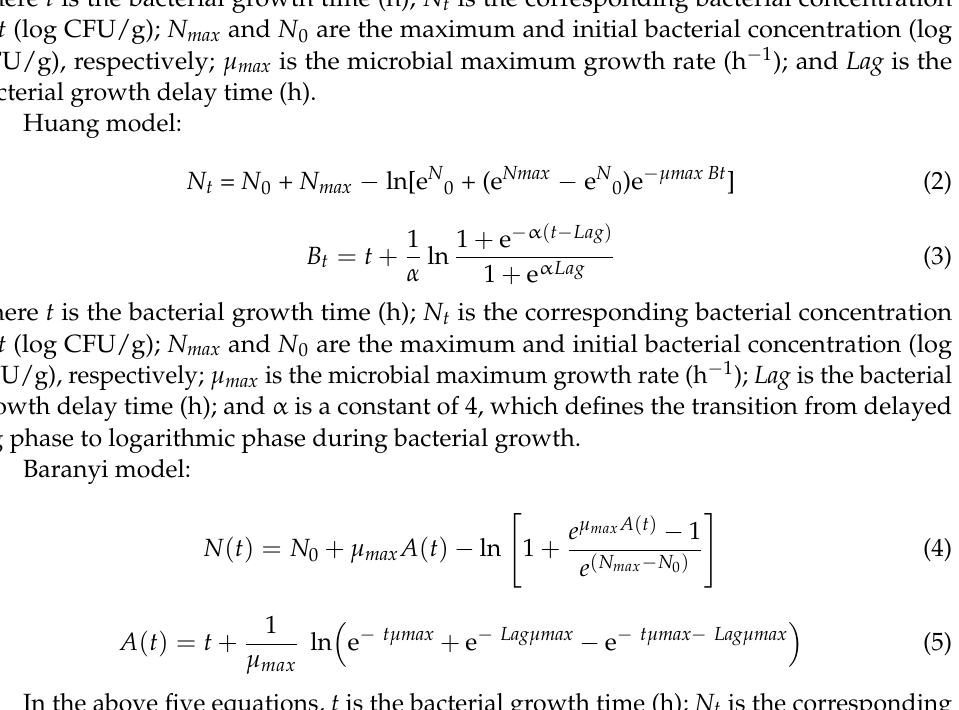
Table 5. Sensory evaluation criteria. Grade Sensory Traits Quality Bright red, milky-white fat, shiny, quick recovery from 5 acupressure, slightly dry appearance, non-sticky, normal odor Bright red, slightly darkened fat, slightly reduced luster, 4 recovered after acupressure, slightly wet, slightly sticky, normal odor Color appears slightly darker, decreased luster, recovery of 3 acupressure becomes slow, slightly wet, slightly sticky, no clear odor change Dark red, slightly greenish fat, very slow recovery of 2 acupressure, moist, sticky, with a peculiar smell Dark red, green surface, no recovery of acupressure, a large 1 amount of mucus, very sticky, with a pungent smell